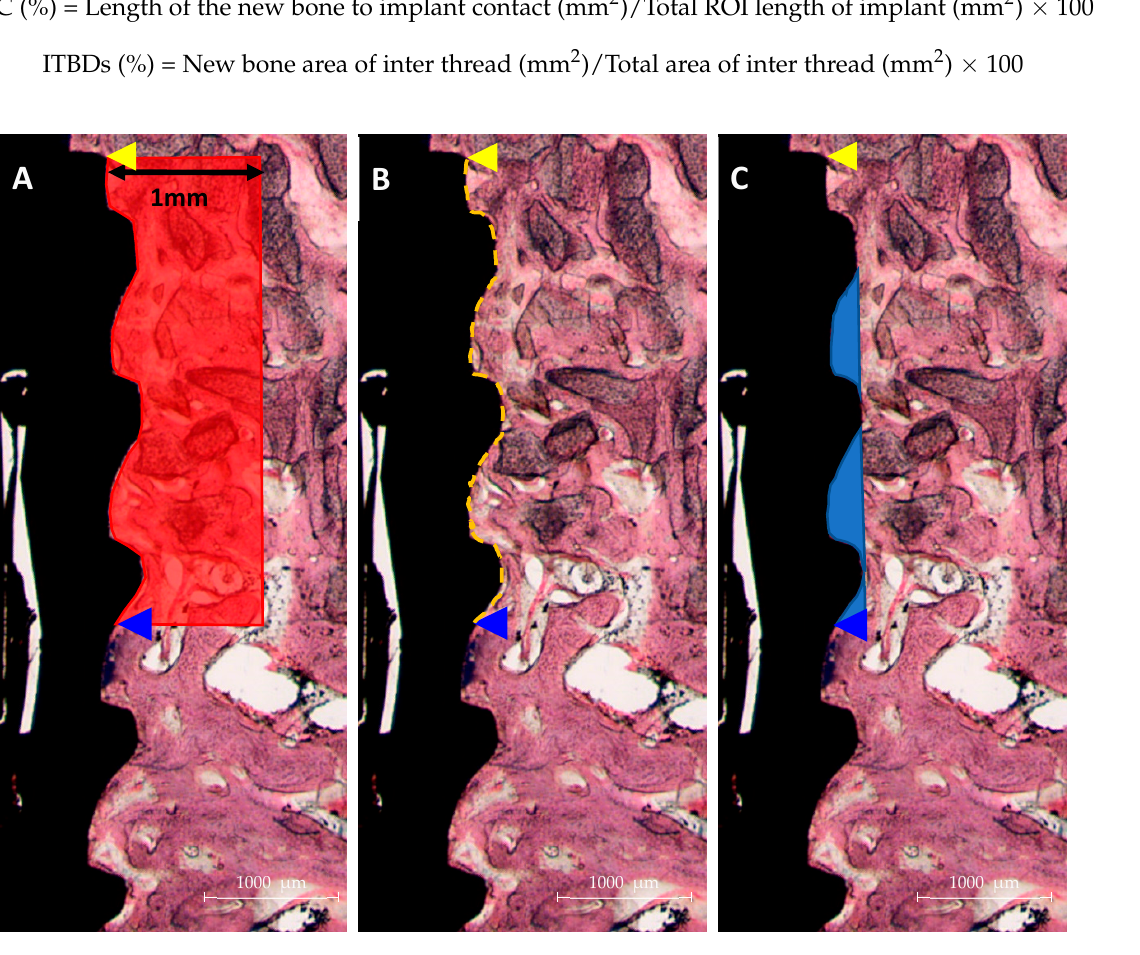
Figure 3. Histometric measurements in regions of interest (ROIs). ROIs were fixed from implant platforms to the third thread and at 1 mm around implants in occlusal view. ( A ) NBA: New bone area, ( B ) BIC: Bone-to-implant contact, ( C ) ITBD: Inter-thread bone density.